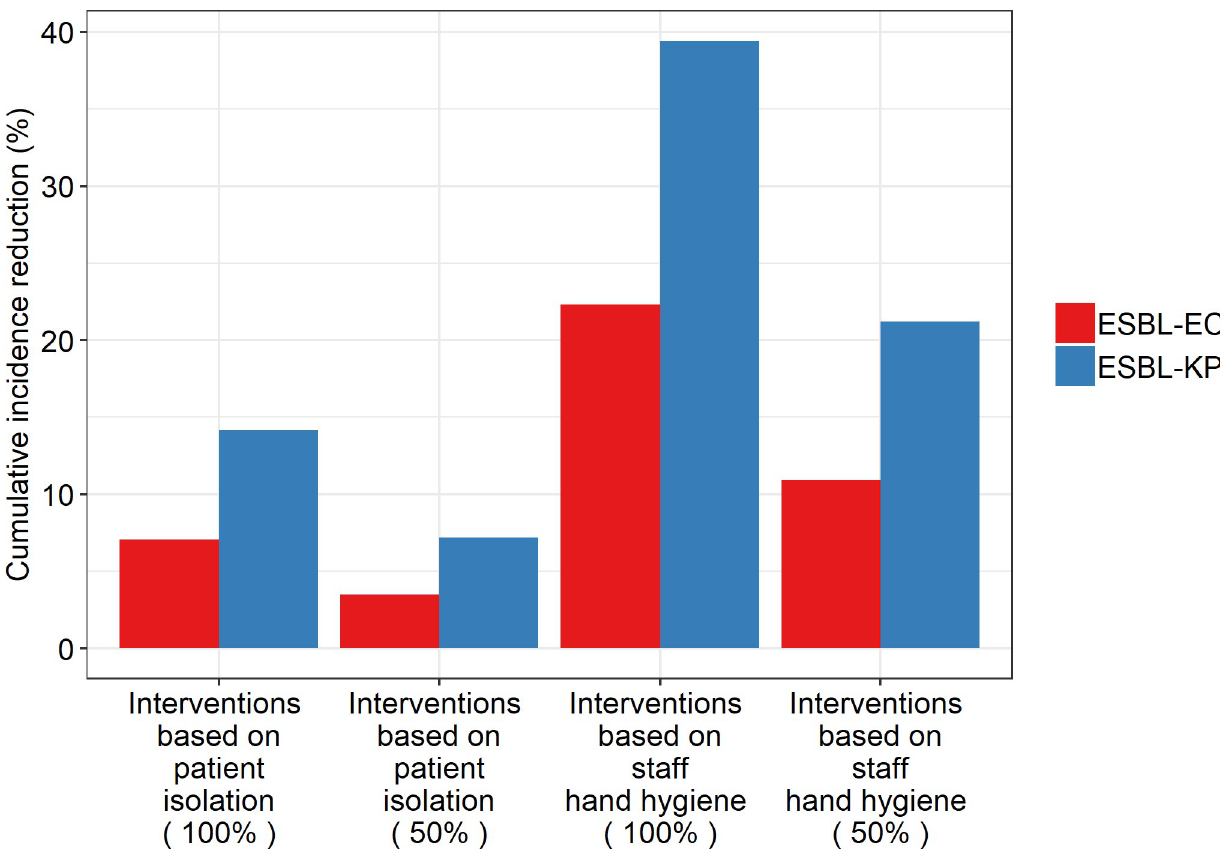
Fig 2. Predicted reduction in the cumulative incidence of ESBL-EC and ESBL-KP under 4 illustrative scenarios, using the mathematical model. For each scenario and each species, the percent reduction in the cumulative incidence compared to the baseline situation (without any control measure) is depicted (red: EC, blue: KP). Interventions based on patient case isolation correspond to a removal of 100% and 50% of patient-patient CPIs. Interventions based on staff hand hygiene correspond to a removal of 100% and 50% of patient-staff CPIs.